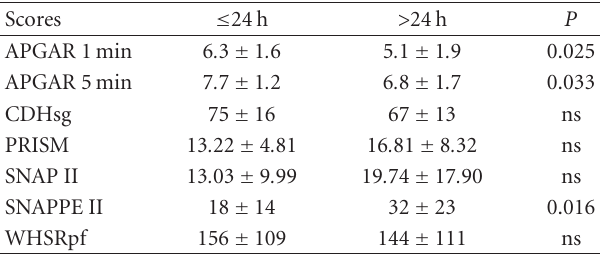
Table 4: Comparison of advanced respiratory therapies and the timing of intensive care and hospital treatment in patients stabilized and submitted to surgery, divided into two groups according to the duration of preoperative stabilization stage ( ≤ 24 hours or > 24